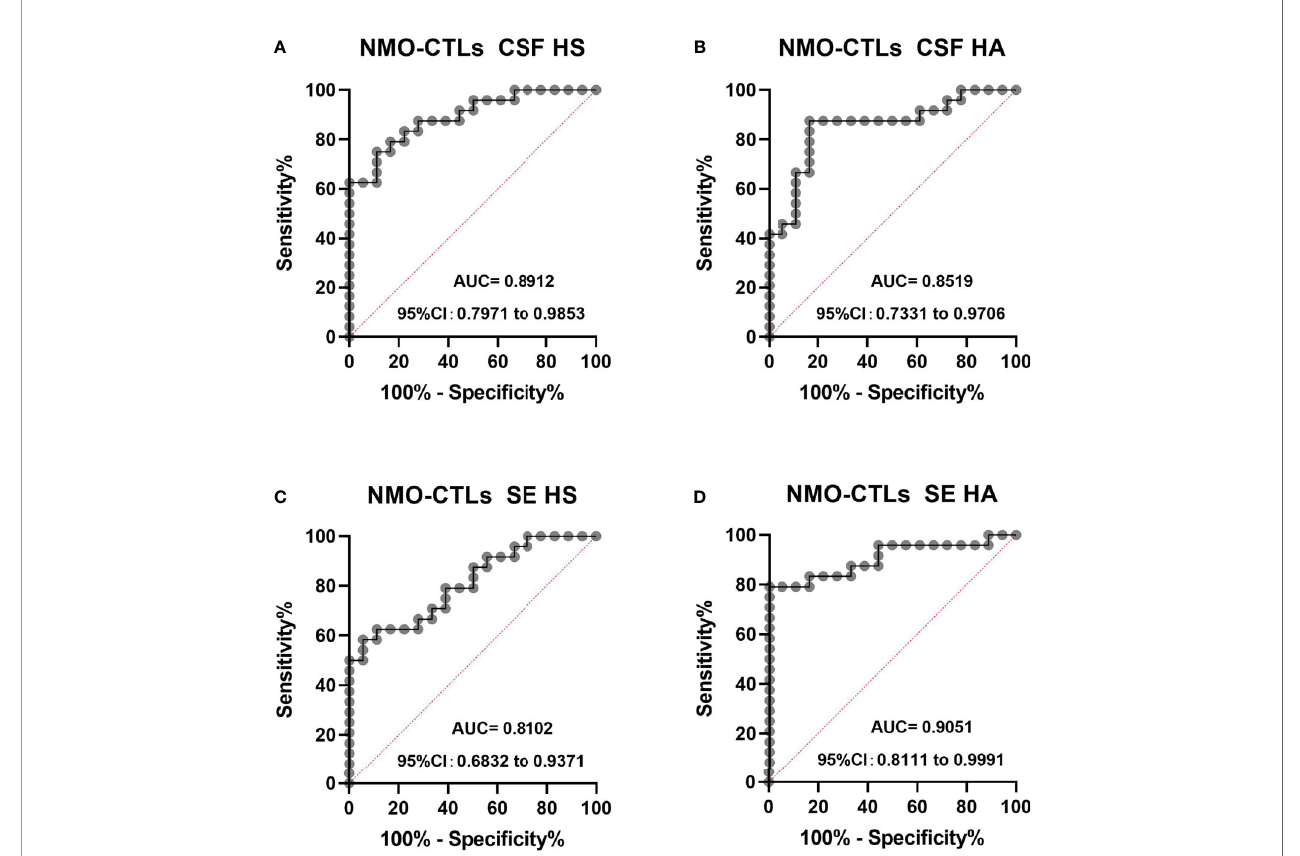
FIGURE 4 | The ROC curve analysis of CSF and plasma HS and HA in NMO patients to distinguish from CTL (A – D) . The area under curve (AUC) for CSF HS in NMO patients to distinguish from CTL patients was 0.819 (95% CI: 0.791-0.9853, P <0.0001) (A) , the AUC for CSF HA was 0.8519 (95% CI: 0.7331-0.9707, P= 0.0001) (B) . The AUC for SE HS was 0.8102 (95% CI: 0.6832-0.9371) (C) , the AUC for SE HA was 0.905 (95% CI: 0.811-0.9991, P <0.0001) (D) . CI, con fi dence